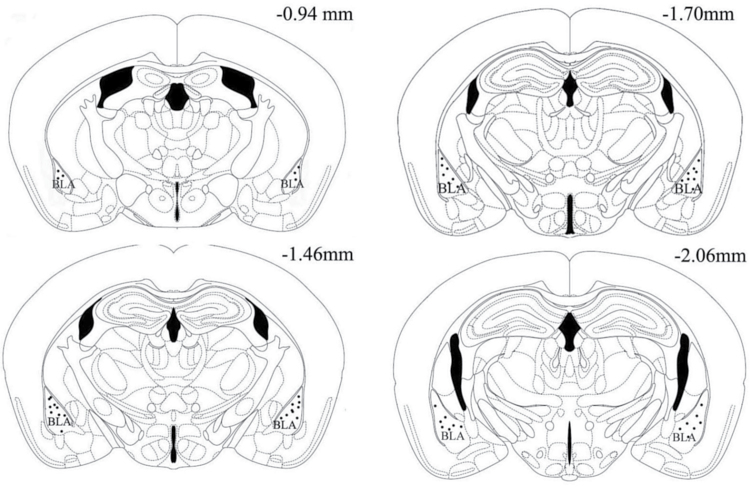
Illustration of the locations of the injection cannula tips in the basolateral amygdala (BLA) in all animals used in the study. Numbers show distances from bregma.